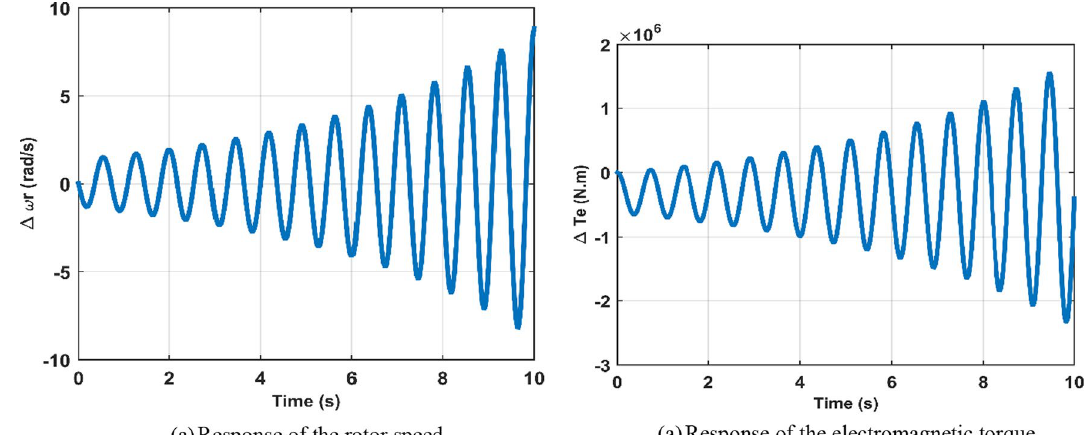
Fig. 6 Response with AVR and deactivated